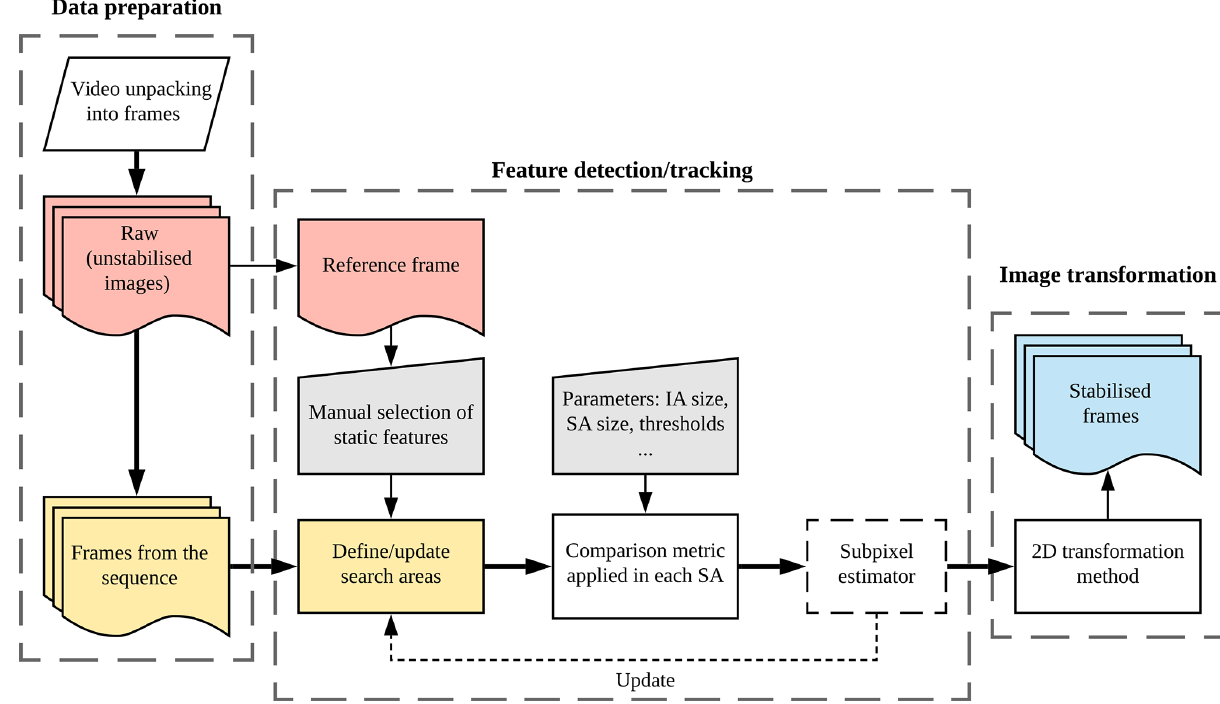
Figure 1. General outline of the manual feature selection/tracking approach. SA – search area; IA – interrogation